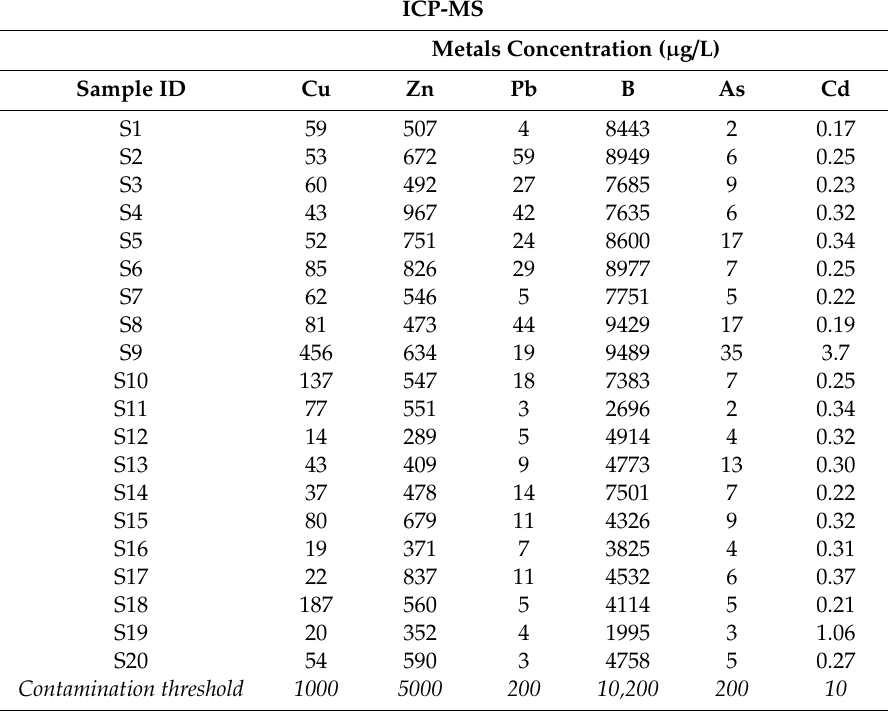
Table 5. Element contents, determined by ICP-MS in the twenty investigated wine